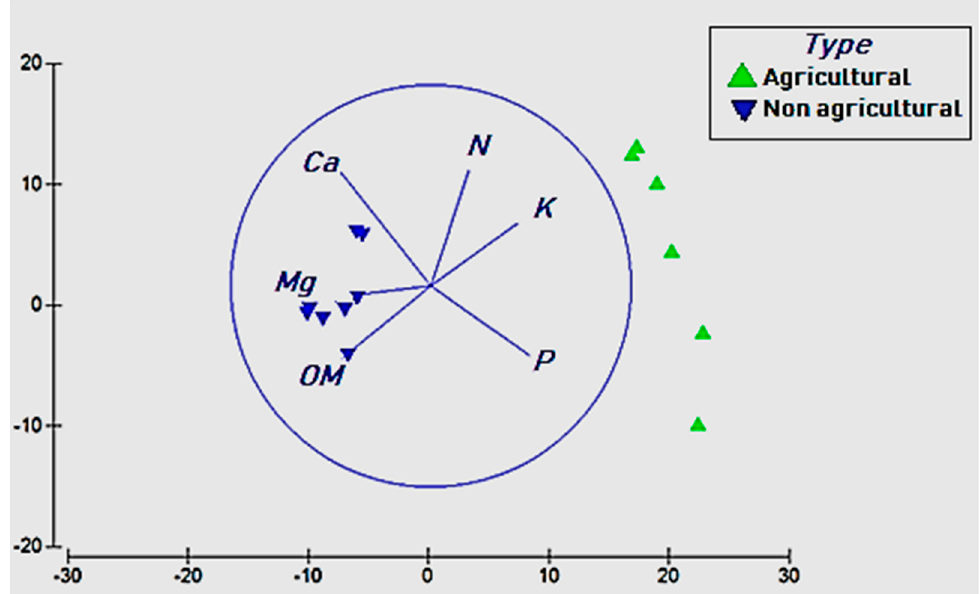
Figure 3. Distance-based redundancy analysis (db-RDA) biplot of a) bacterial communities and soil chemistry parameters. Only the environmental variables that significantly ( p < 0.05) explained variability in microbial community structure are shown (arrows). The direction of the vectors indicates the direction of maximum change of that variable, whereas the length of the vector represents how well the parameter explains the distribution of the data.